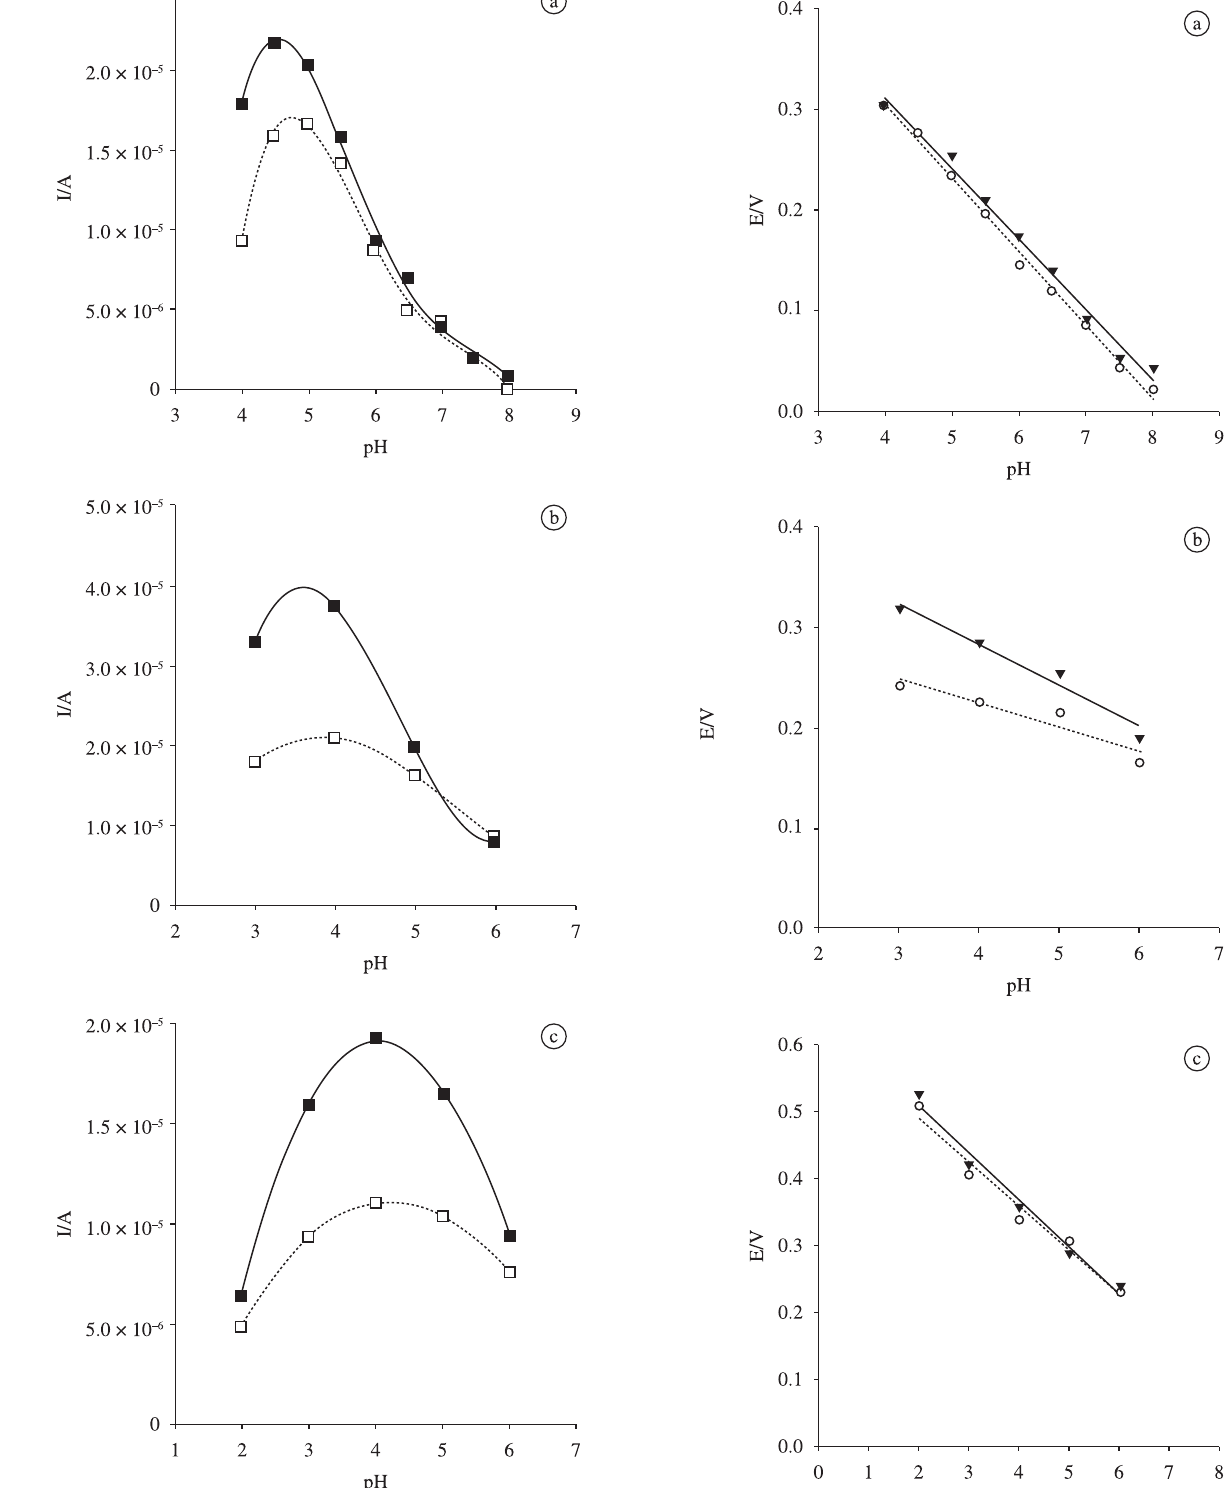
Figure 5. Synthetic representation of the current peaks as a function of pH at both modified electrodes. a) Buffer solutions; phthalate; b) acetate and c) phosphate .